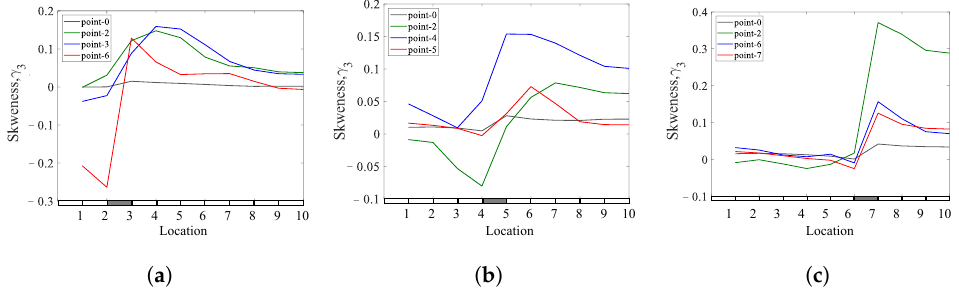
Figure 29. The effect of changing excitation locations on the skewness coefficients of a simply supported beam with a single breathing crack: ( a ) q 1 = 0.25; ( b ) q 2 = 0.45; ( c ) q 3 = 0.65.